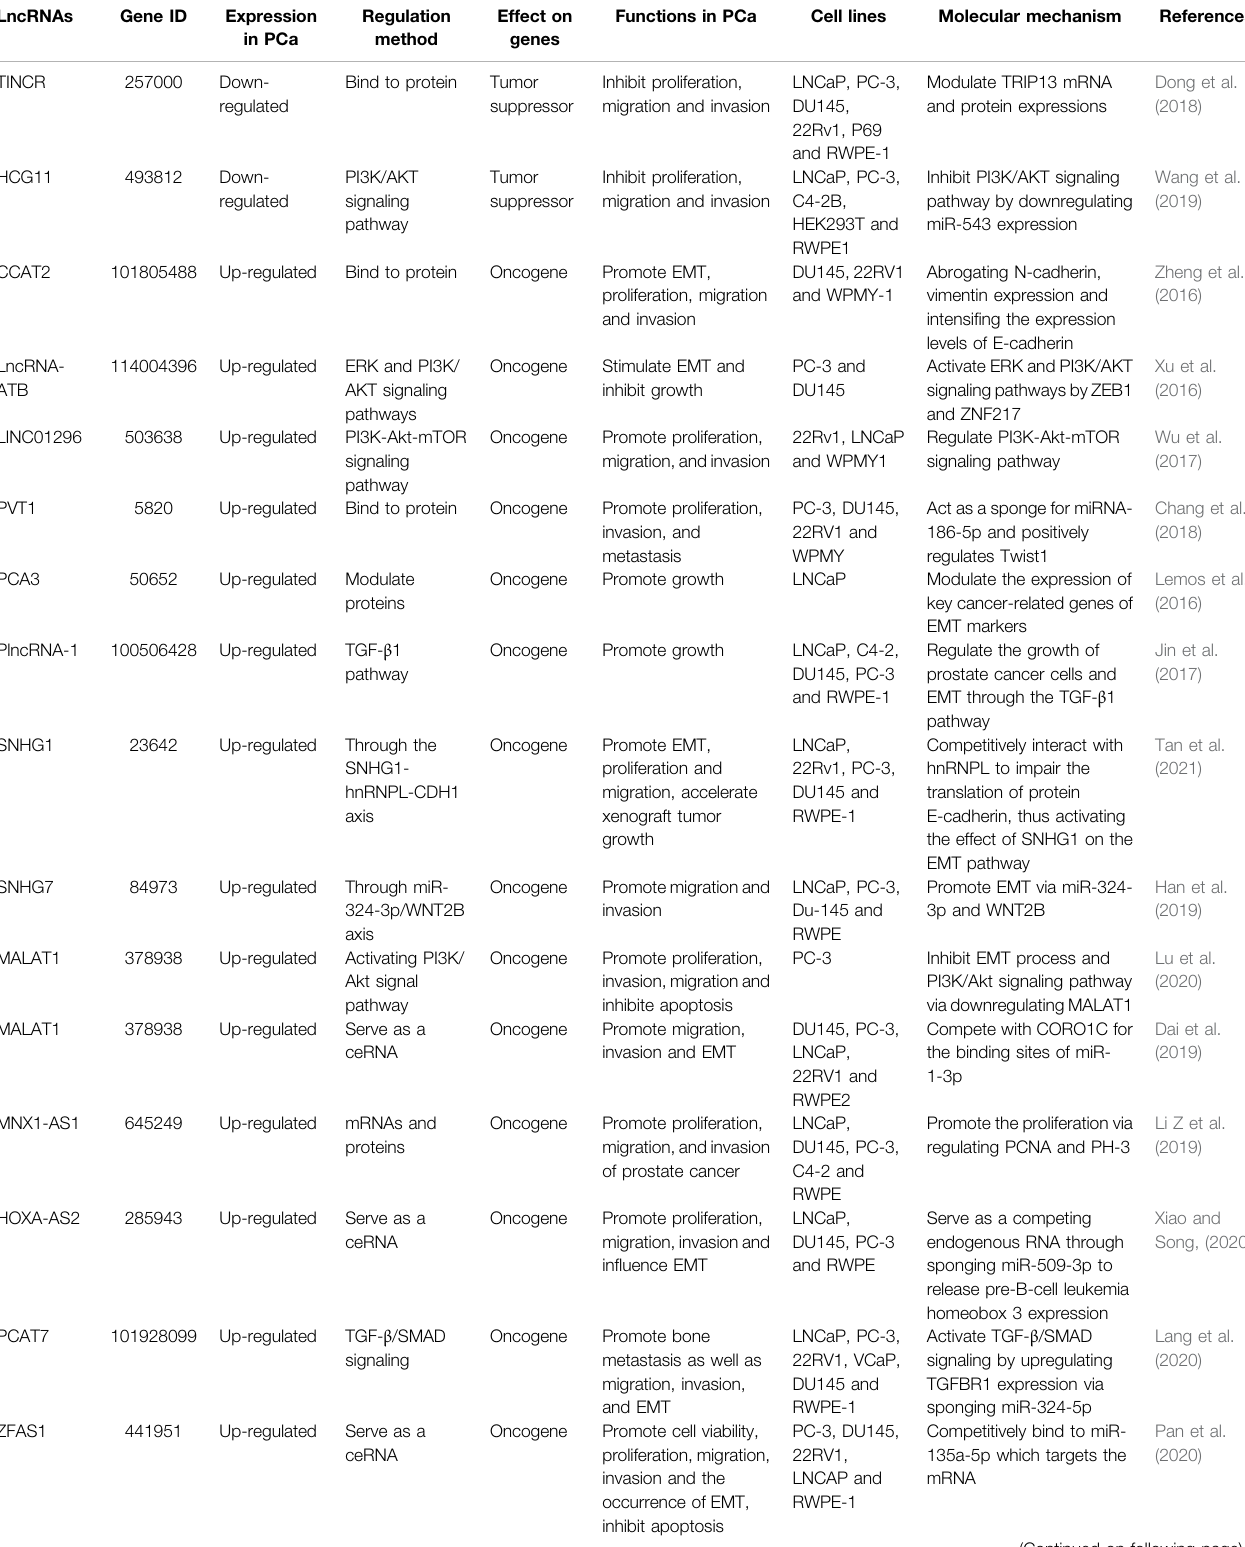
TABLE 1 | Different lncRNAs and their regulation in EMT of